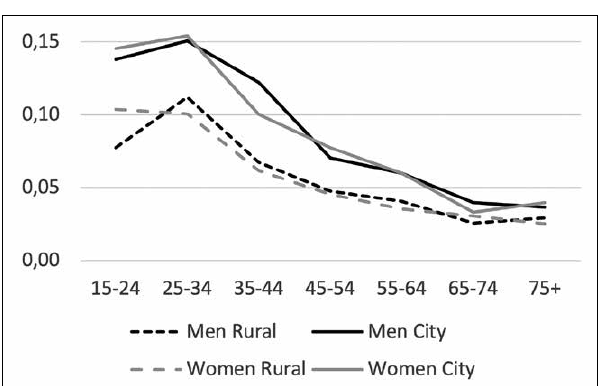
Figure 2a: Fixed-effects linear probability model of housing being a countrywide issue, 3-way interaction age, gender and urbanisation (rural vs city)